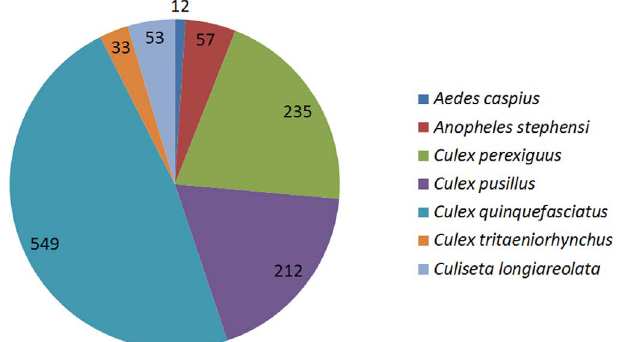
Figure 5. Relative proportions of mosquito species individuals collected during our fi eld surveys in Qatar, September 2017 and January 2019, by any sampling method, for a total number of 1,151